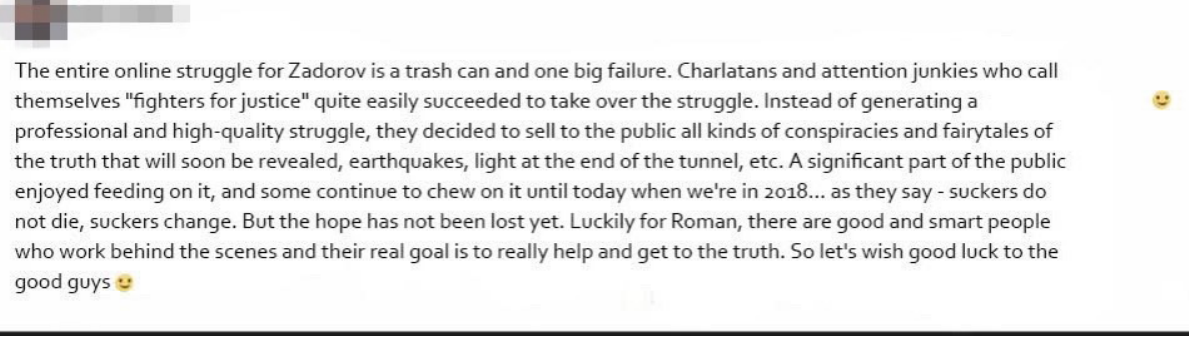
Figure 1. Good and bad